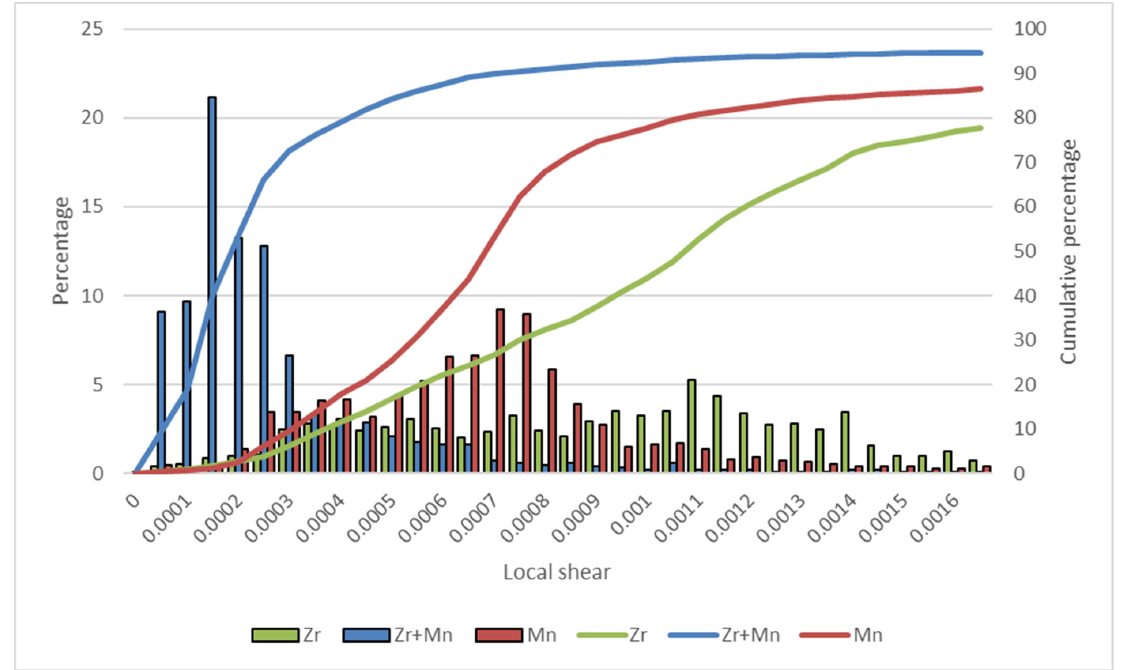
Figure 6. Local shear distribution from DDD simulations at ε = 0.01% for three comparable simulations to identify the effect of each dispersoid type. For each of the three simulations, the position of the dispersoids and Frank–Read sources are kept the same.